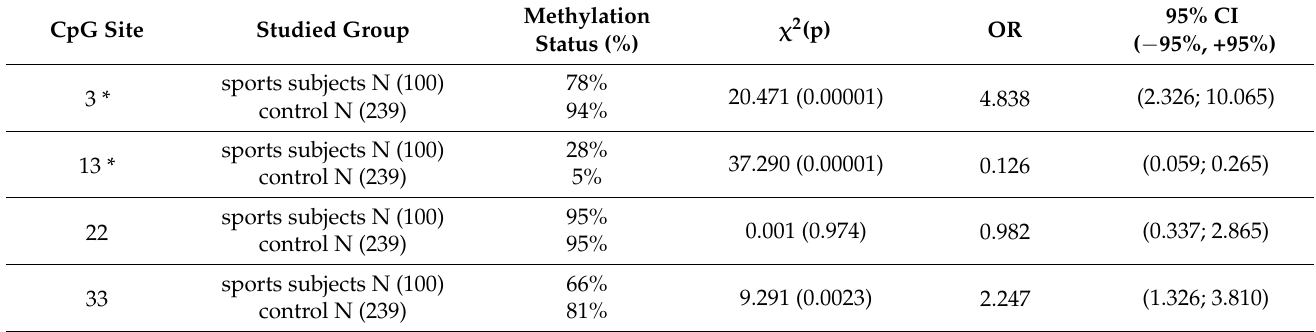
Table 1. Methylation status of PAX5 4 DAT1 CpG sites (3, 13,22,33) in sports subjects and control group. A group of 100 sports and 239 control individuals were studied to compare methylation status in indicated CpG sites. Chi-square test χ 2 (p), Chi-square; OR, odds ratio; CI, Confidence Interval; ( − 95%, +95%) [14].